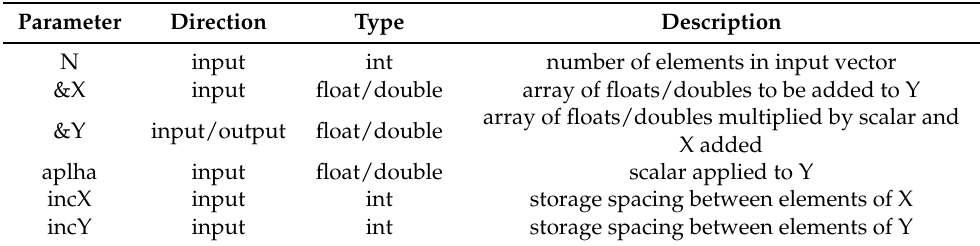
Table 4. Input and output parameters for kernel xpay